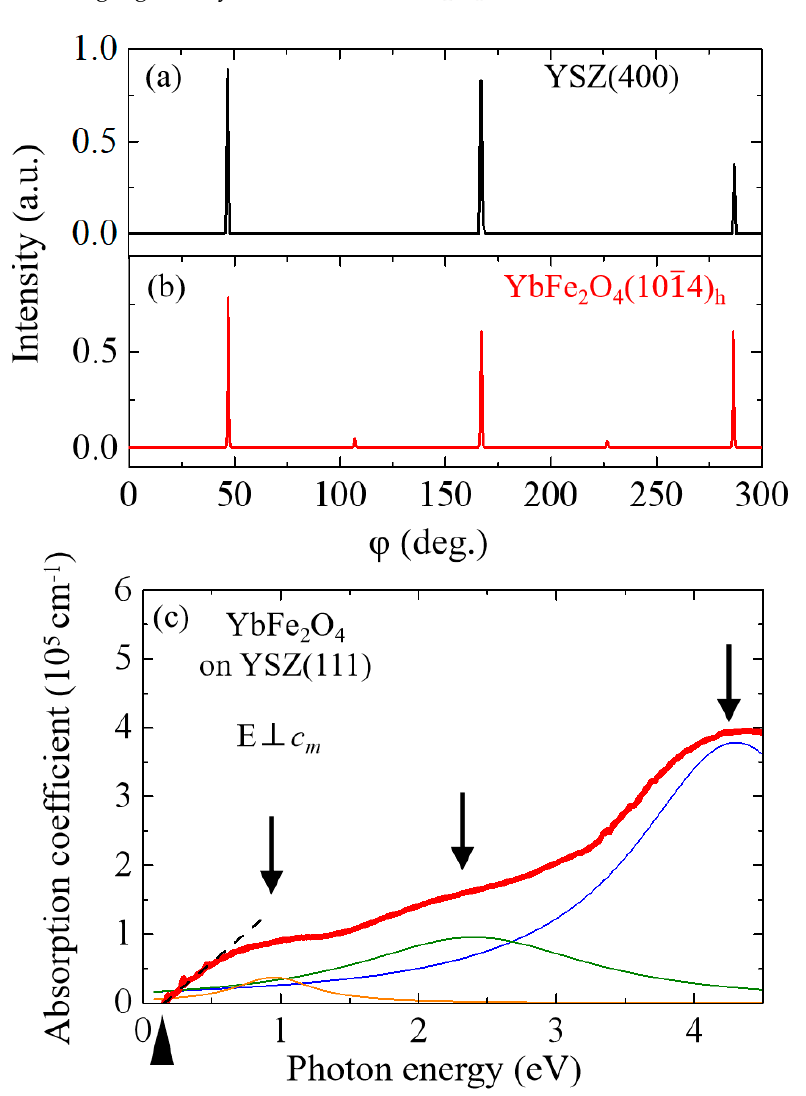
Figure 2. ( a ) Azimuth angle dependence of the (400) Bragg reflection for YSZ substrate. ( b ) Azimuth angle dependence of the (1014) h Bragg reflection for YbFe 2 O 4 thin film. ( c ) In-plane absorption coefficient spectrum of YbFe 2 O 4 thin film.